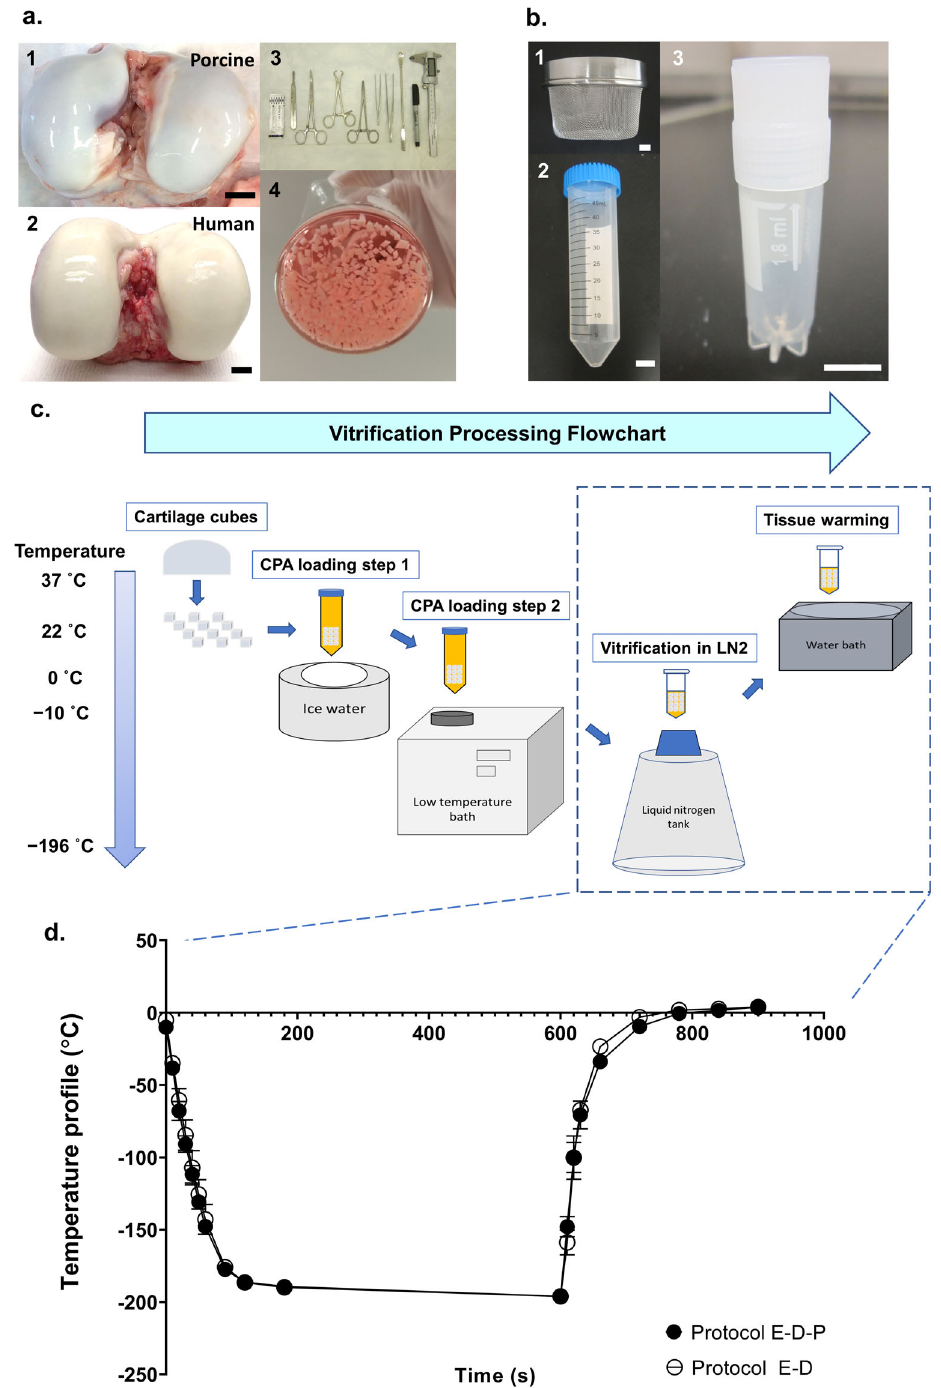
Fig. 2 Vitri fi cation process of particulated articular cartilage. a Harvesting articular cartilage cubes from fresh healthy knee joints. 1 A typical porcine sti fl e joint with exposed fresh healthy femoral condyles. 2 A typical human knee with exposed fresh healthy femoral condyles. 3 The surgical tool set, from left to right: #20 steel surgical blade, surgical scalpel handle, curved forceps, towel forceps, straight forceps, non- toothed tissue forceps, toothed tissue forceps, double-ended spoon, Sharpie marker, and digital caliper. 4 Cartilage prepared into 1 mm 3 pieces and placed in medium before vitri fi cation. b The vitri fi cation tool set. 1 Mesh strainer used for transferring cartilage cubes. 2 The 50 mL Falcon tube for cryoprotectant loading into articular cartilage. 3 1.8 mL Cryovial for sample vitri fi cation and storage in liquid nitrogen. c Flowchart of the vitri fi cation process for articular cartilage. Weighed cartilage cubes were transferred into a 50 mL prepared multicryoprotectant solution at the concentration, time, and temperature listed in Fig. 1b under loading step 1, followed by a second solution at the condition listed under loading step 2 in Fig. 1b. Once cryoprotectant permeation was fi nished, cartilage cubes were quickly transferred into a 1.8 mL Cryovial tube and plunged into liquid nitrogen on a Cryovial cane. Upon cartilage rewarming on day 0 or on day 180, the Cryovial tube was removed from the liquid nitrogen and plunged into a 37 °C water bath for warming the glassy cartilage, following by cryoprotectant removal and chondrocyte assessments. d Temperature pro fi le. The thermal history of the vitri fi cation and rewarming processes of Protocol E – D – P and Protocol E – D ( n = 5 replicates per group). Error bars = SD. All data are represented as mean ± SD. Scale bar = 10